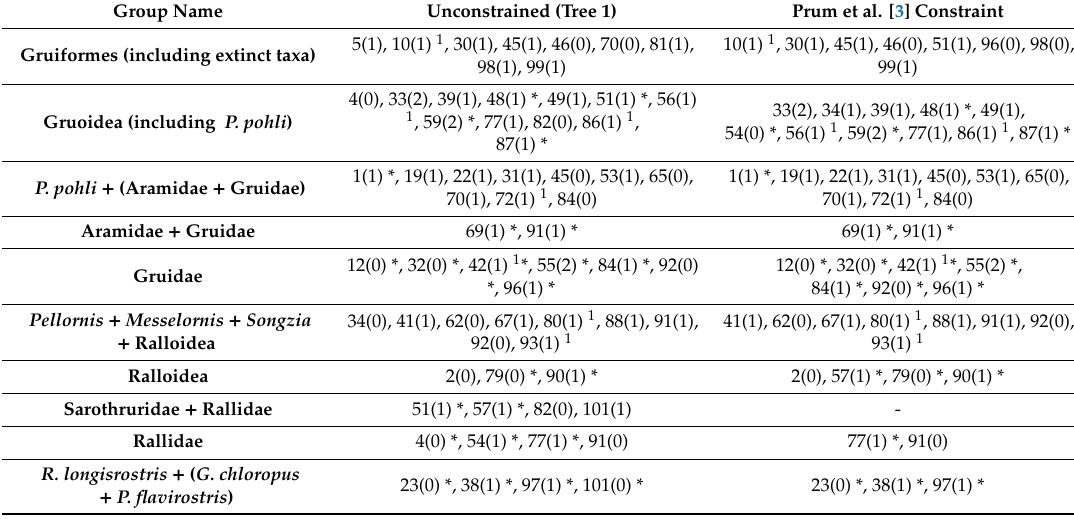
Table 4. Optimized synapomorphies of selected groups recovered through unconstrained and constrained analyses employing the molecular backbone constraint of Prum et al. [3] with Australlus and Itardiornis excluded. Superscripts of 1 denote synapomorphies with CI = 1.0. Asterisks indicate unambiguous synapomorphies. Dashes indicate groups that were unresolved in strict consensus trees, although all optimized synapomorphies are reported for the unresolved group containing Pellornis , Messelornis and Songzia